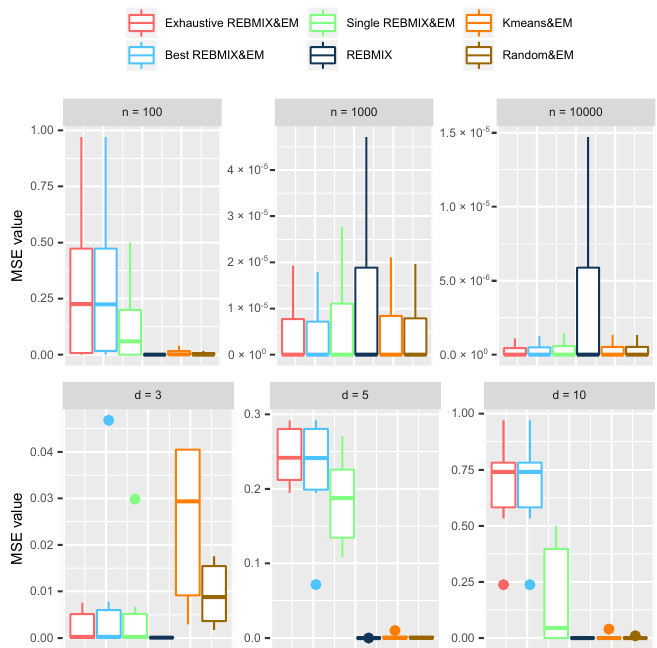
Figure 6. Density-estimation performance evaluation of Exhaustive REBMIX&EM strategy, Best REBMIX&EM strategy, Single REBMIX&EM strategy, Kmeans&EM, Random&EM and REBMIX on the artificial datasets; First row: Plots given are grouped by the number of observations n . Second row: Plots are grouped by the dimension d of the dataset for the n = 100 observations in the